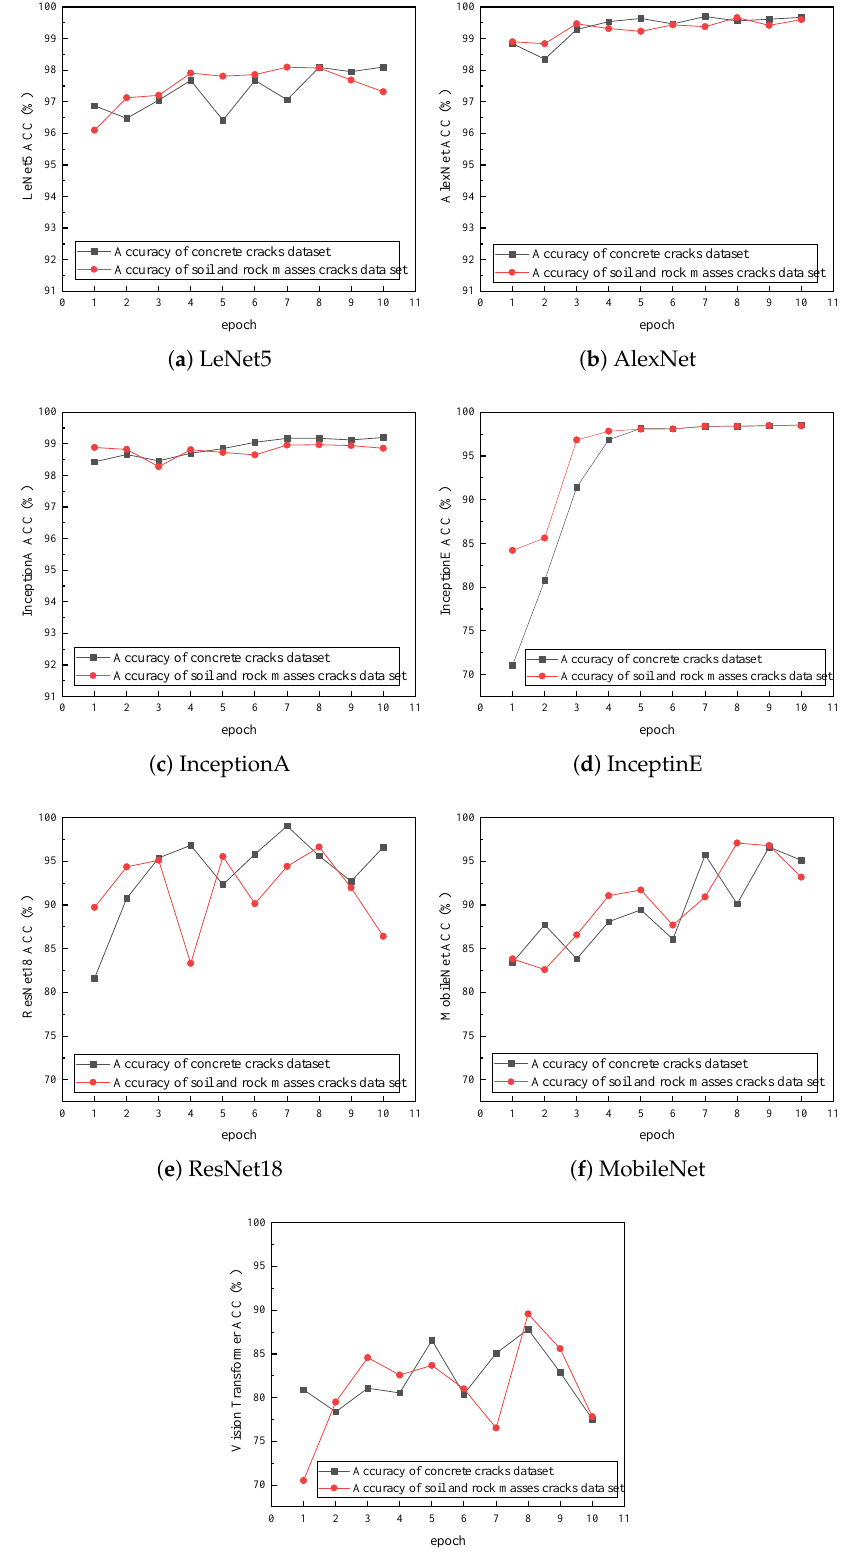
Figure 16. Comparison of the accuracy of the identification of surface cracks of soil and rock masses and concrete cracks of each